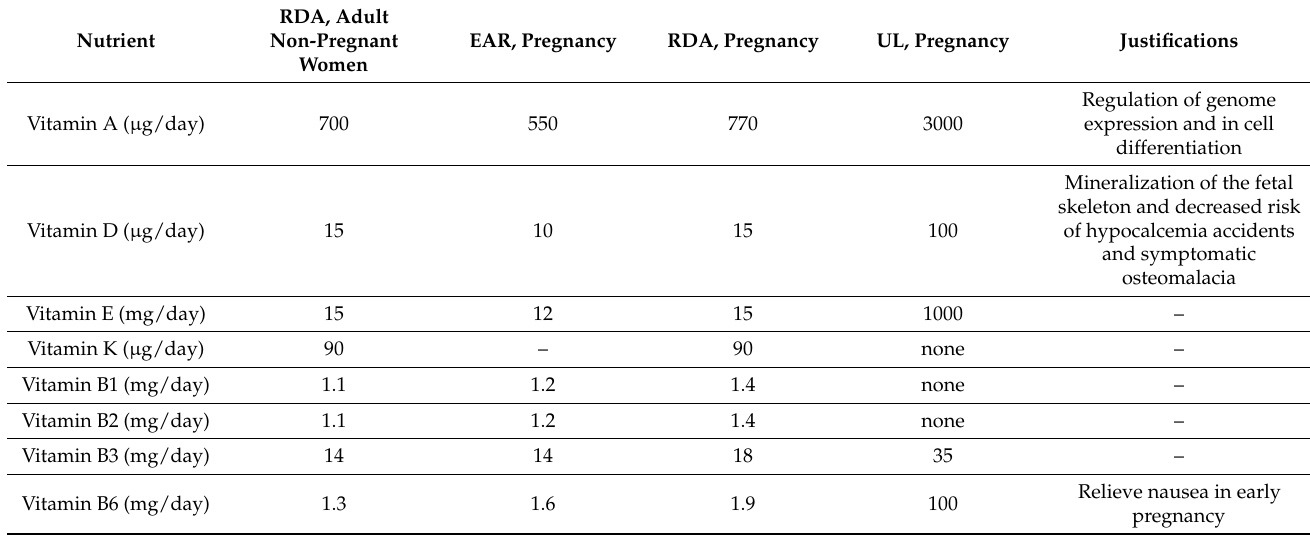
Table 1. Recommended dietary allowances (RDA) for non-pregnant women and estimated average requirements (EAR), RDA, and tolerable upper intake level (UL) for pregnant women. Adapted from Medeiros et al. [63], Kominiarek et al. [17], and Allen